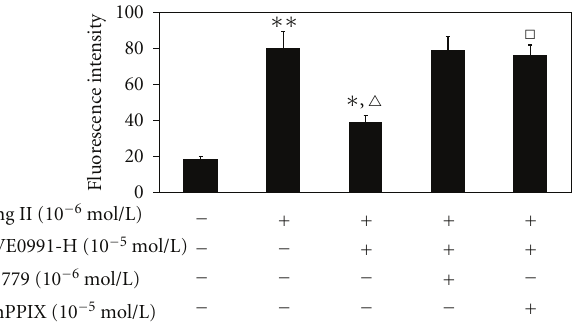
Figure 6: The e ff ect of AVE0991 on Ang II-stimulated ROS production in VSMCs that were pretreated with the HO-1 inhibitor ZnPPIX. ∗ P < 0 . 05; ∗∗ P < 0 . 01 versus control group; (cid:5) P < 0 . 01 versus Ang II group; (cid:2) P < 0 . 01 versus Ang II + AVE0991 group; n =